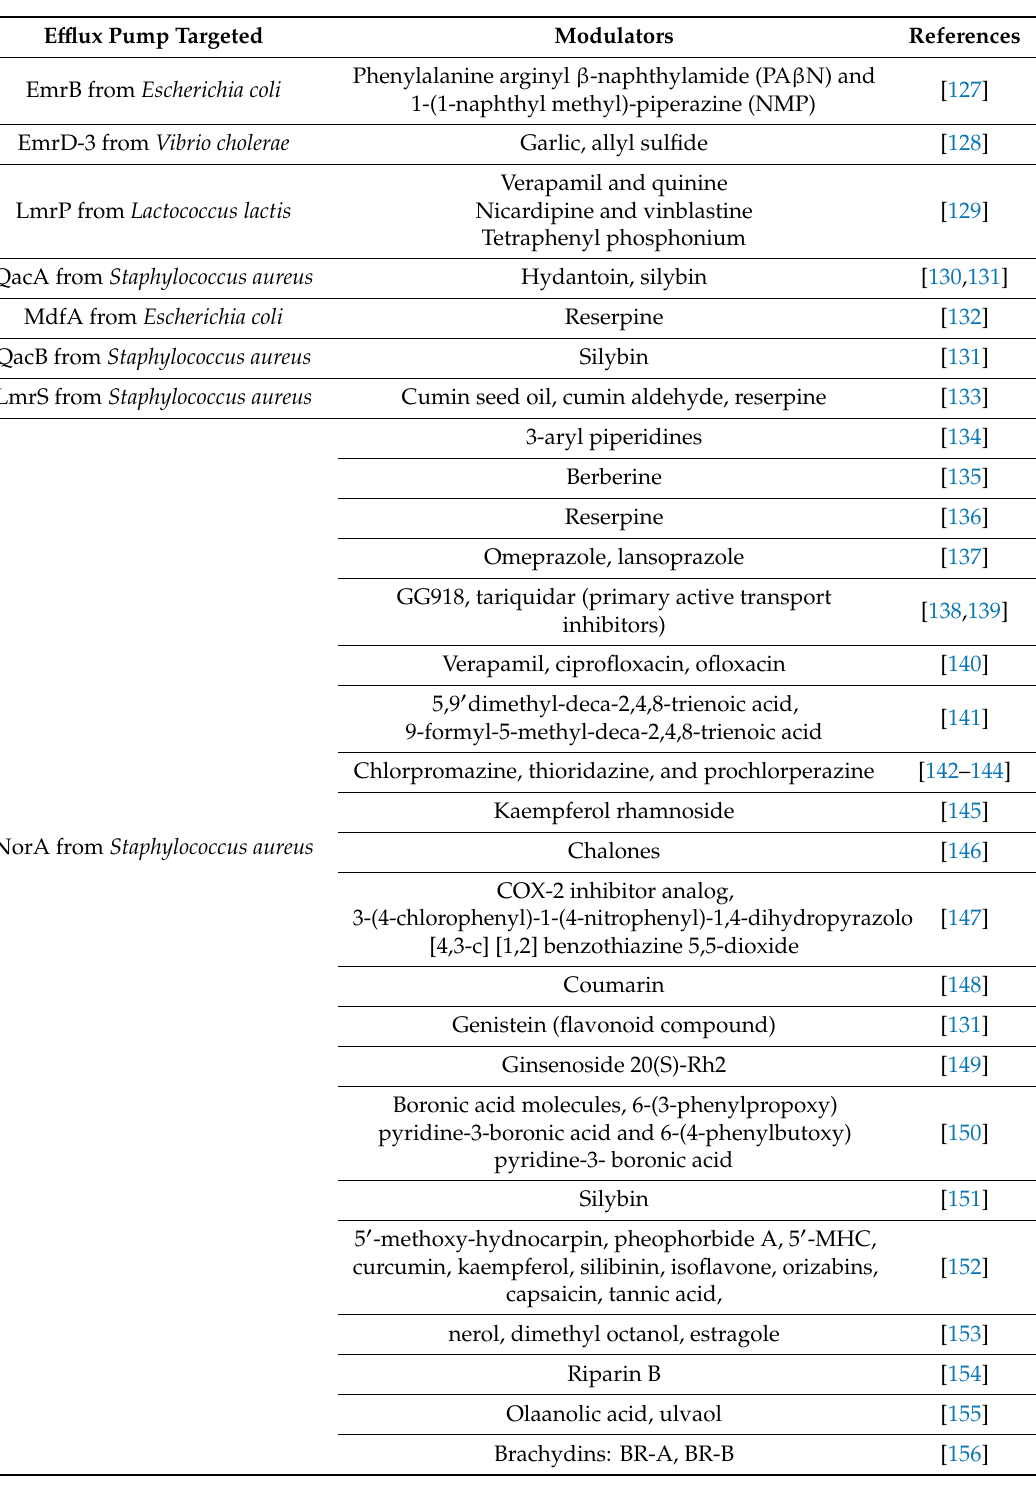
Table 1. Some examples of various modulators of antimicrobial e ffl ux in some bacterial e ffl ux pumps from the major facilitator